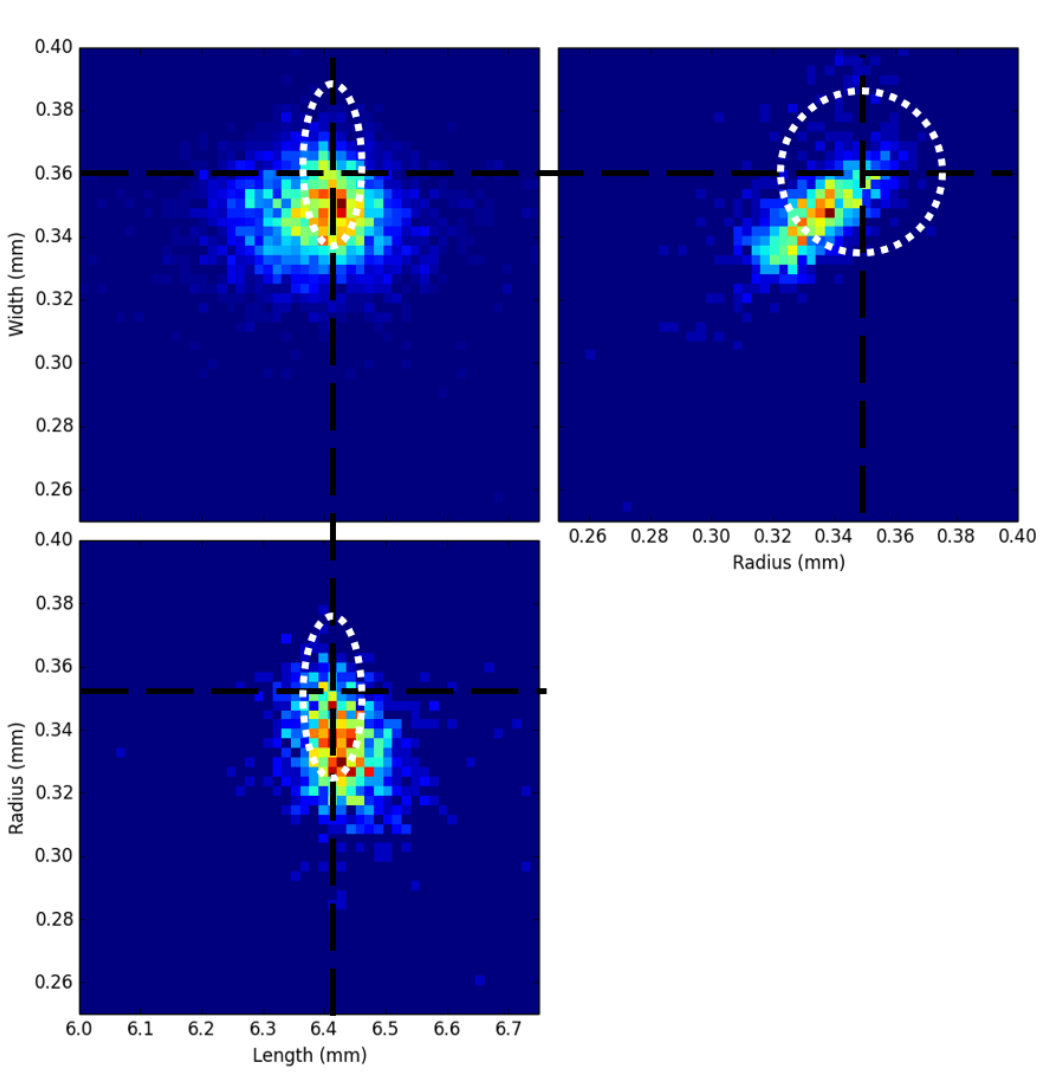
Figure A13. Correlation between arm length, arm width, and center radius. Color scale is normalized to probability density ranging from blue to red. Black lines indicate the target values and the white ellipses indicate the acceptable